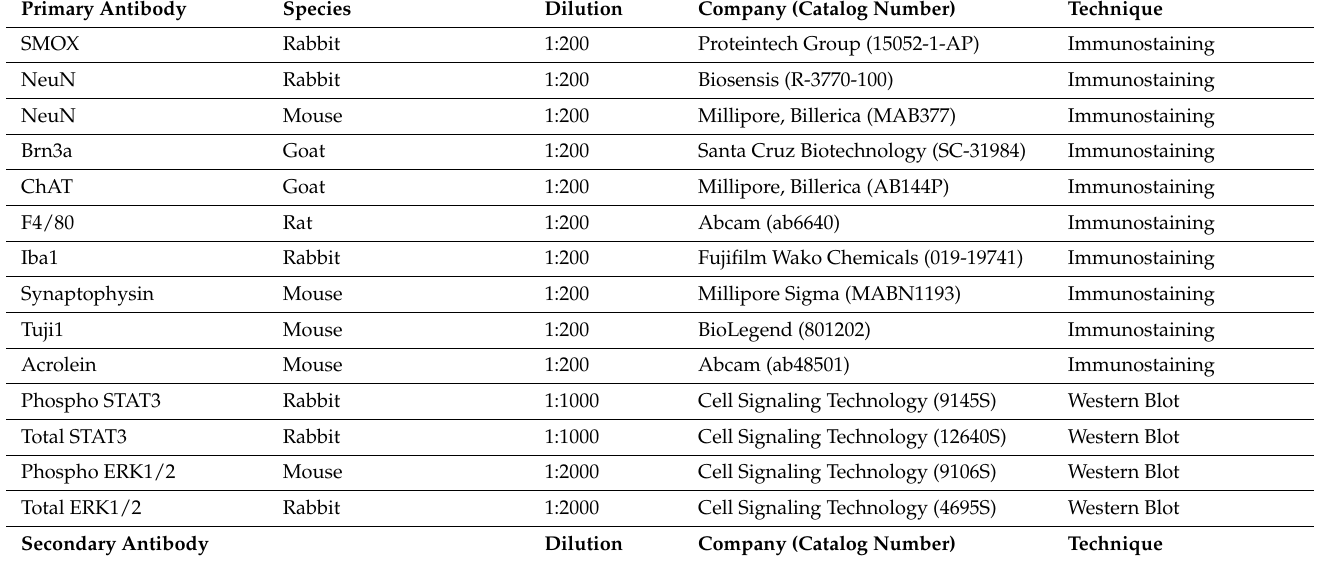
Table 1. List of antibodies used in the